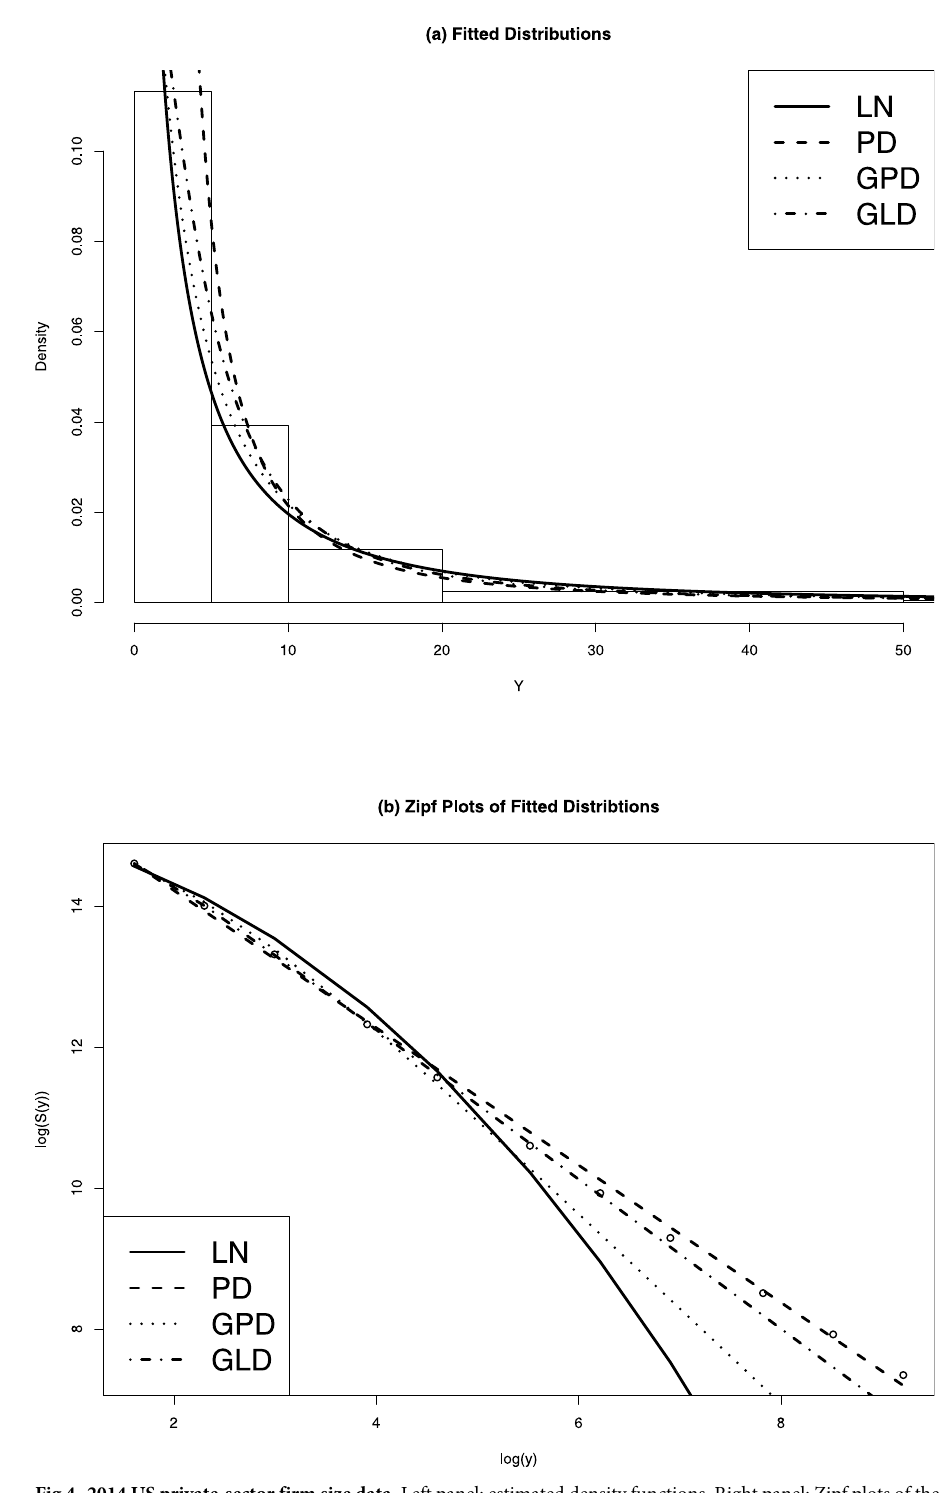
PLOS ONE | https://doi.org/10.1371/journal.pone.0235282 July 15,